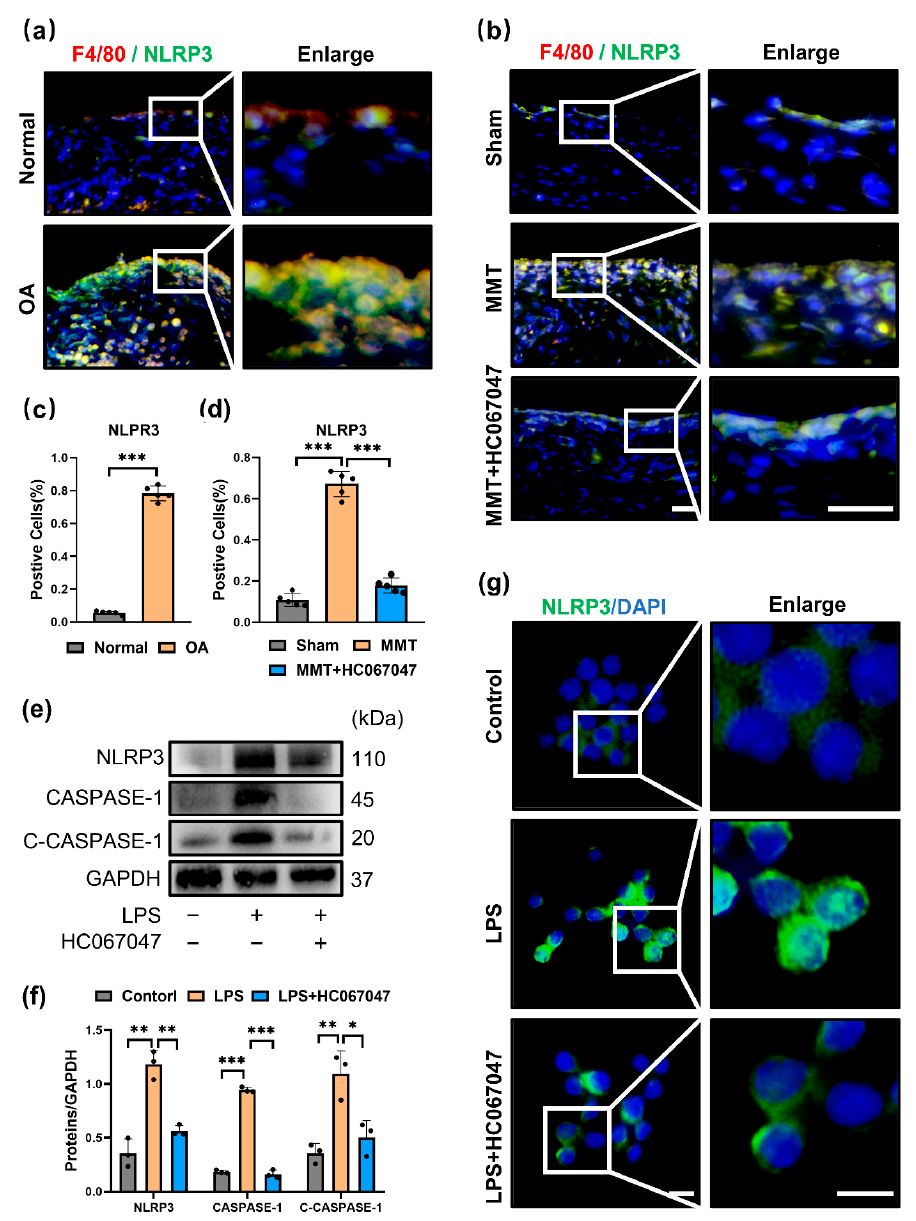
Figure 4. TRPV4 blockade inhibits the NLRP3 inflammasome ( a ) NLRP3 and F4/80 co-immunoflu- orescence in the normal and OA human synovium. ( b ) NLRP3 and F4/80 co-immunofluorescence in the synovium of the sham, MMT, and MMT + HC067047 groups (Scale bar: 50 µm). ( c ) NLRP3-positive cell quantification in human synovium. normal human synovium sample = 3, OA human synovium sample = 6. Unpaired two-tailed t -test, *** p < 0.001. ( d ) NLRP3-positive cell quantification of animal sample. n = 5. One-way ANOVA with Tukey’s post-hoc test, *** p < 0.001. ( e ) Western blot analysis of NLRP3, CASPASE-1, and cleaved CASPASE-1 (C-CASPASE-1) in the cells after intervention with LPS with or without HC067047 for 24 h. ( f ) Quantitation of Western blotting; n = 3. One-way ANOVA with Tukey’s post-hoc test, * p < 0.05; ** p < 0.01; *** p < 0.001. ( g ) Immunofluorescence staining of NLRP3 in the cells. All data are shown as mean ±